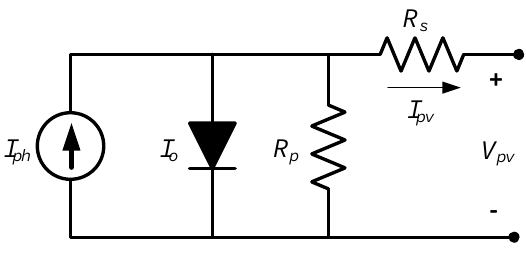
Figure 1. PV cell equivalent circuit.